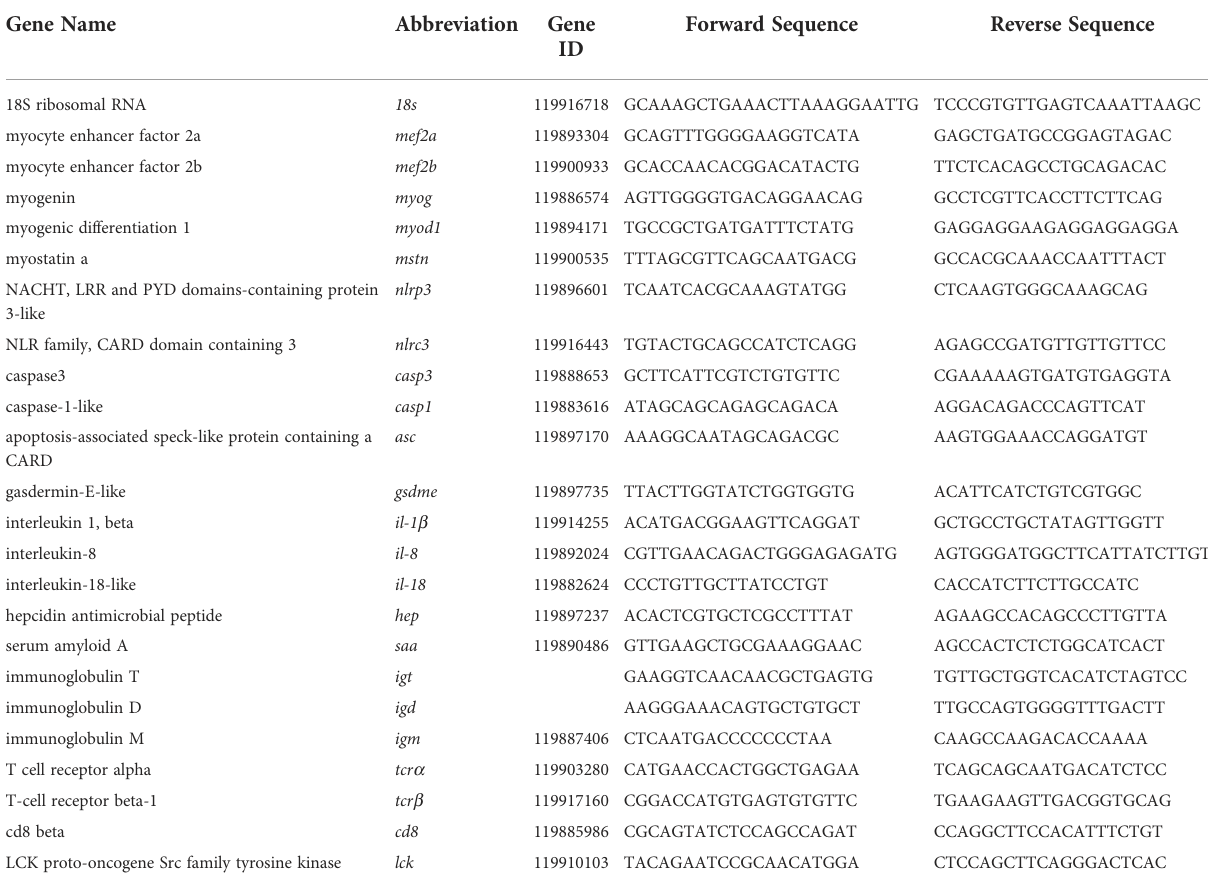
TABLE 2 Primers used in the present